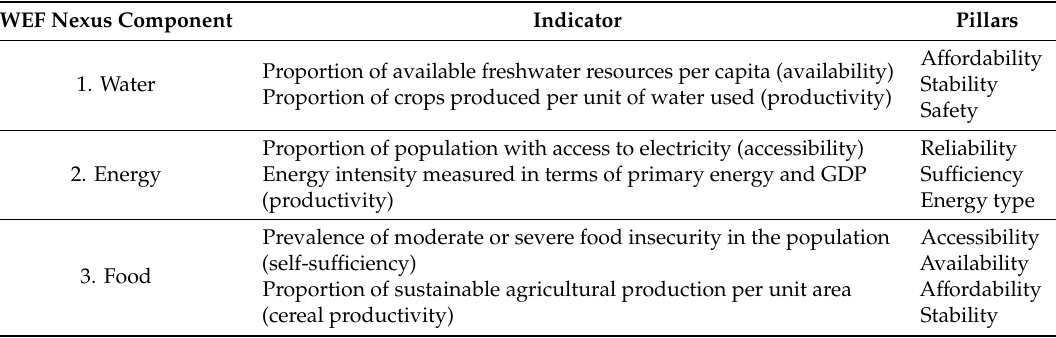
Table 1. Indicators and sub-indicators for the WEF nexus